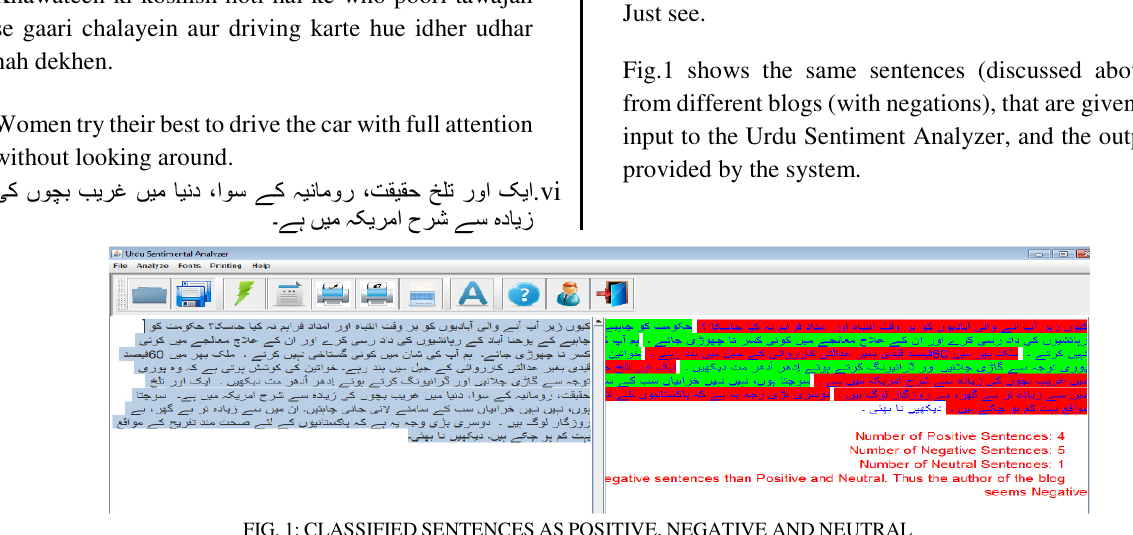
FIG. 1: CLASSIFIED SENTENCES AS POSITIVE, NEGATIVE AND